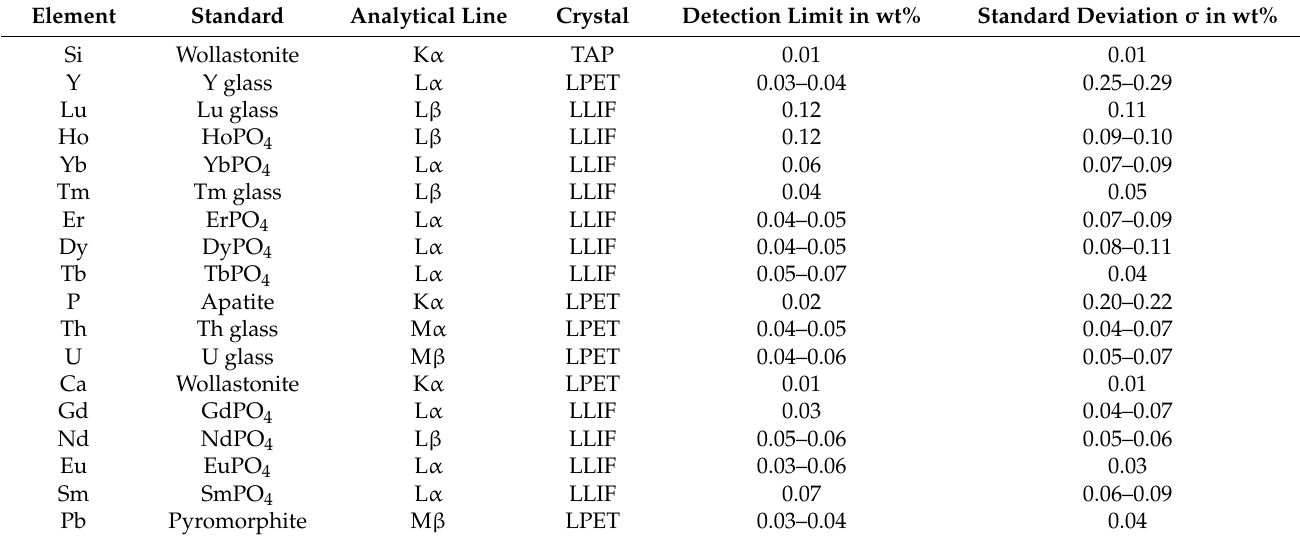
Table 1. Conditions EMP